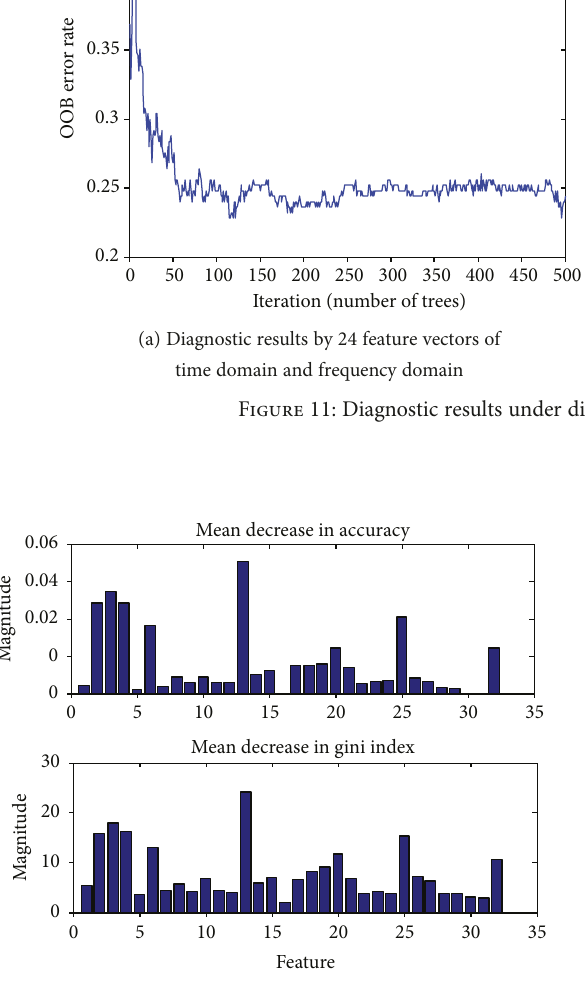
Figure 12: Estimation of the importance of all characteristic